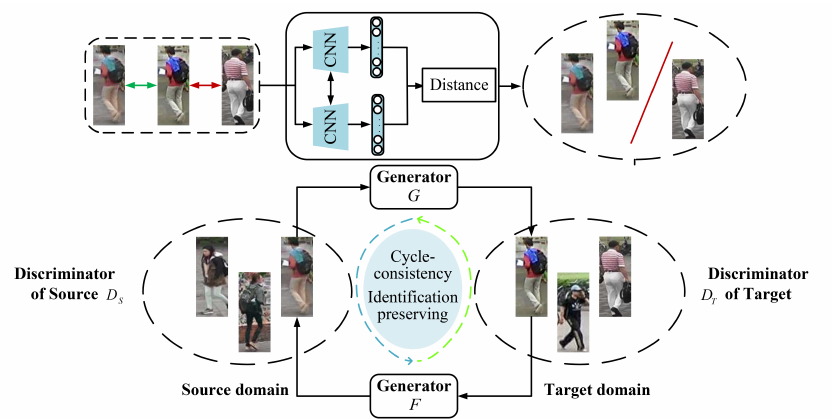
Figure 5. The structure of Strans (Style transfer